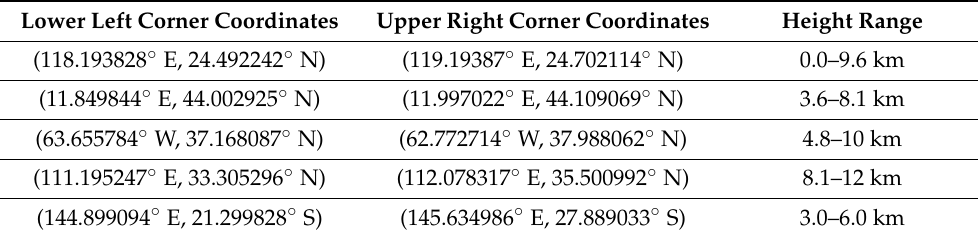
Table 9. Geographical information of the test area.